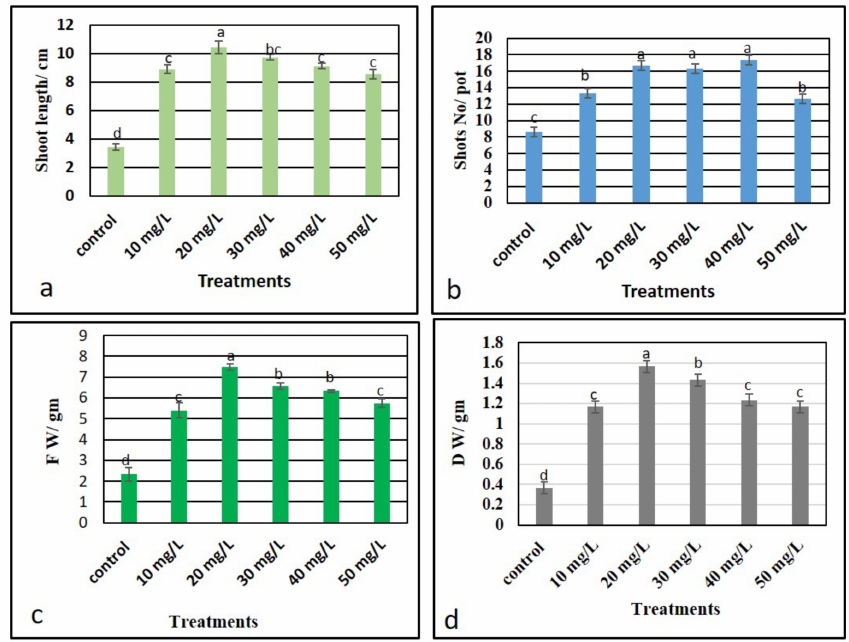
Figure 4. Influence of AgNPs on the in vitro regeneration of M. oblongifolia after 45 days of treatment in MS media: shoot length ( a ); shoot number ( b ); fresh weight ( c ); and dry weight ( d ). Means ± SD for each treatment followed by the same letters are not significantly different according to one-way analysis of variance ( p ≤